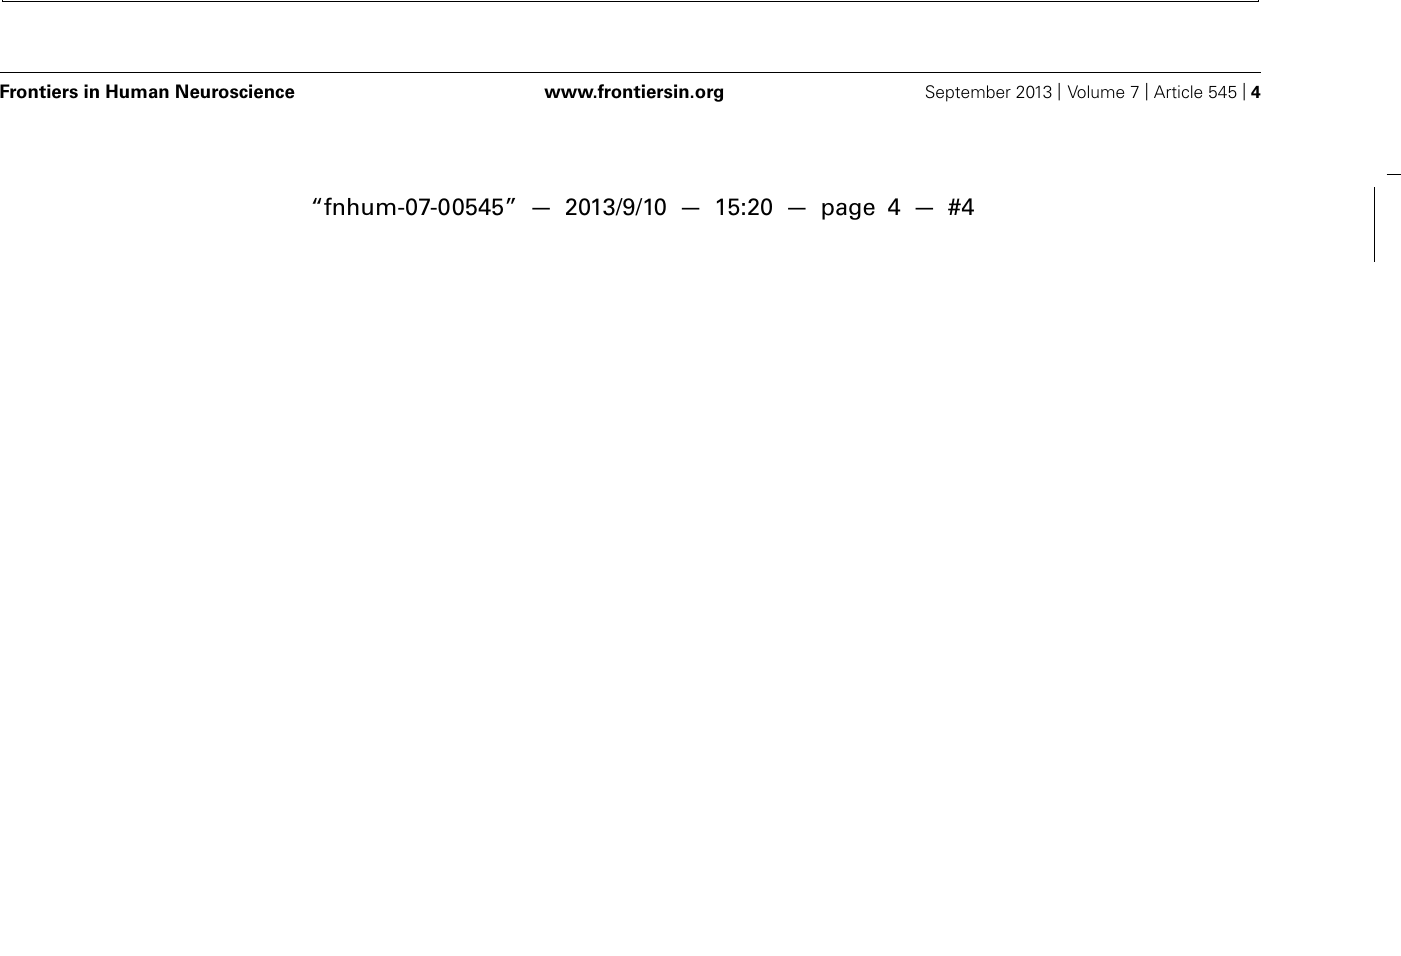
FIGURE 1 | Craving/dreaming pathways: Neurop, neuropeptides; GABA, gamma amino butyric acid, CB, cannabinoid.